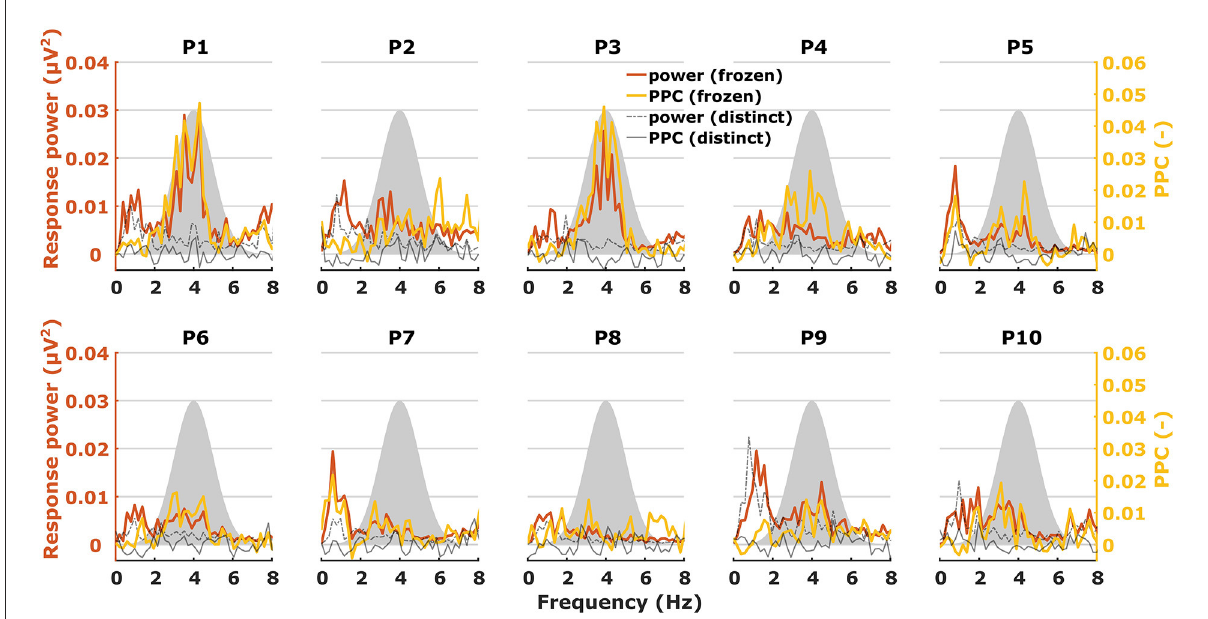
FIGURE6 Two different patterns, one of power (red) and one of PPC (yellow), plotted over each other across modulation frequency. The patterns are from TEMPEST syllabic-like responses in the left hemispheric channel for each participant. Black patterns describe the baseline from distinct responses. The shaded Gaussian curve represents the modulation frequency distribution of the stimuli (scaled